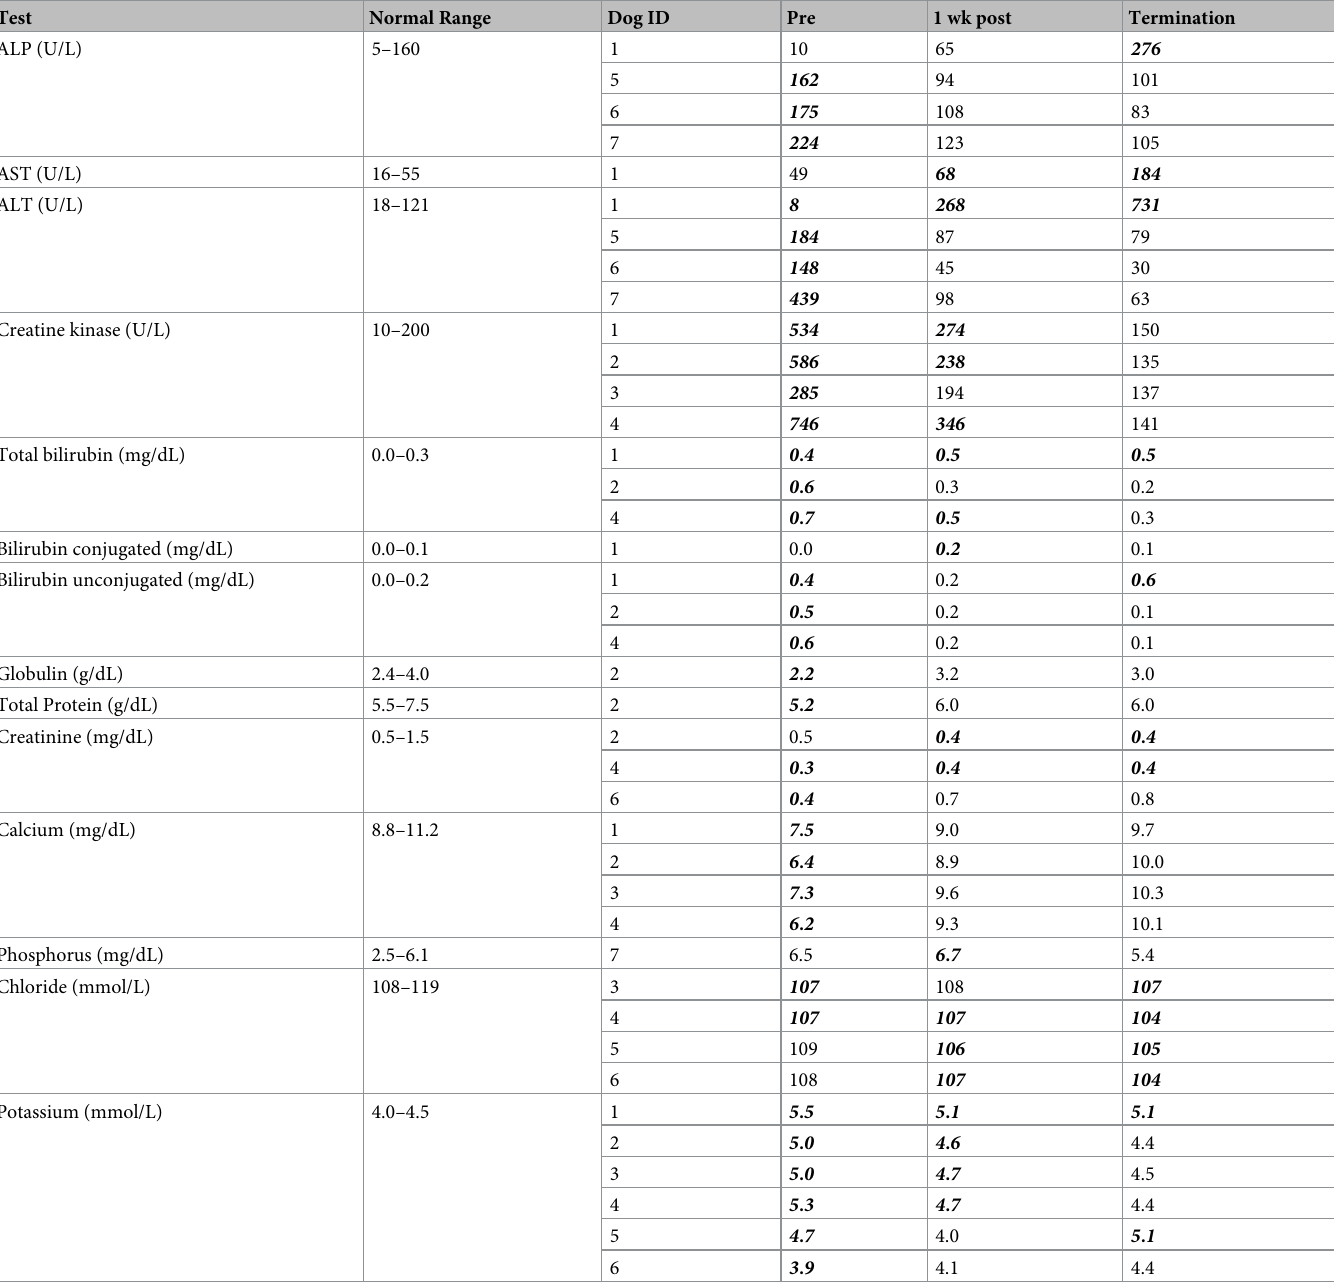
Table 6. Abnormal blood chemistry